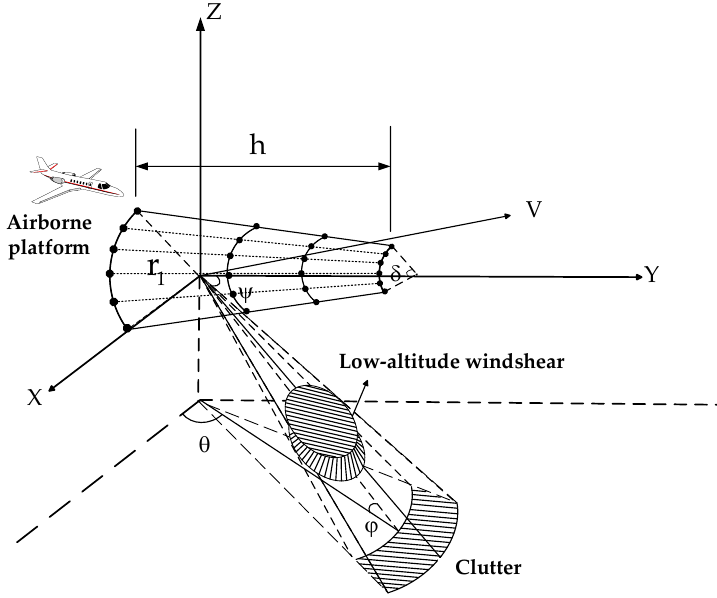
Figure 1. Fuselage frustum conformal array radar model.